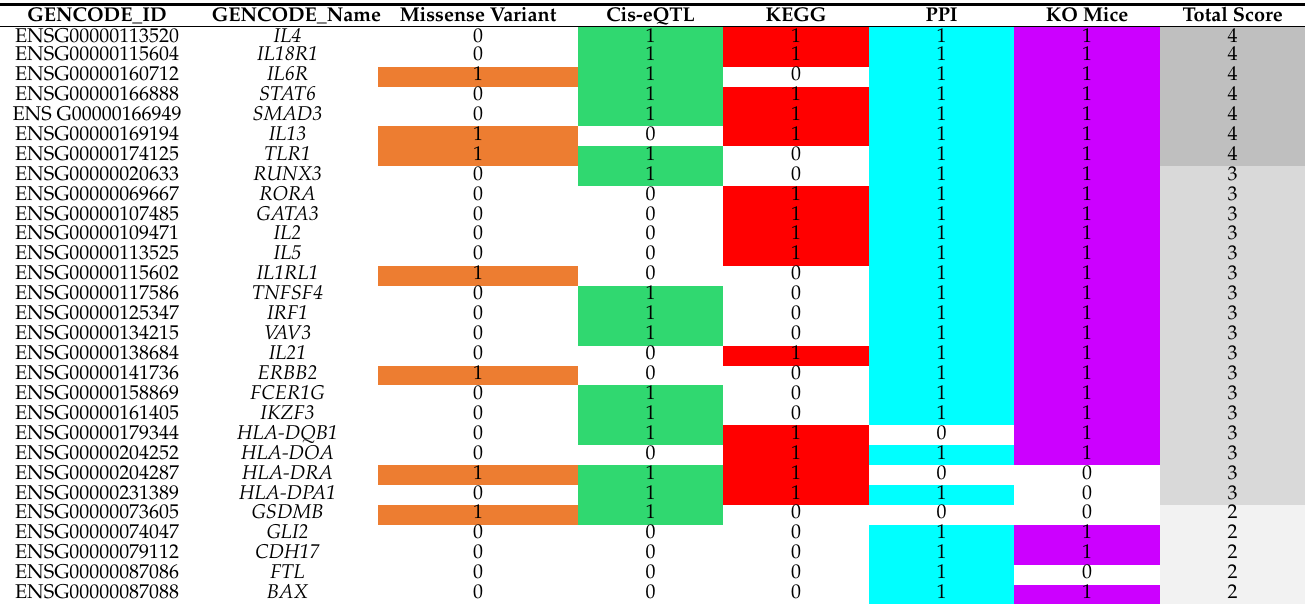
Figure 3. Histogram distribution of gene scores: 460 and 111 genes had scores of 0 and 1, respec- tively; the 65 genes wi th total scores ≥2 were identified as “depression risk genes”. Table 1. Five functional annotations applied to prioritize the depression risk genes.